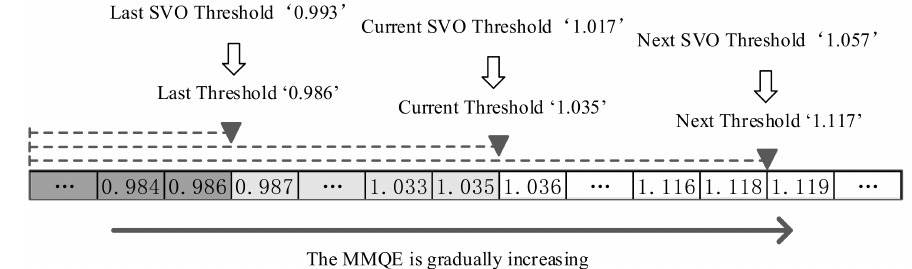
Figure 11. Hierarchical model corresponding to the SVO threshold. The diagram shows three hierarchical states. Each state has a corresponding SVO threshold and MMQE. Moreover, with the increase of the SVO threshold, MMQE also